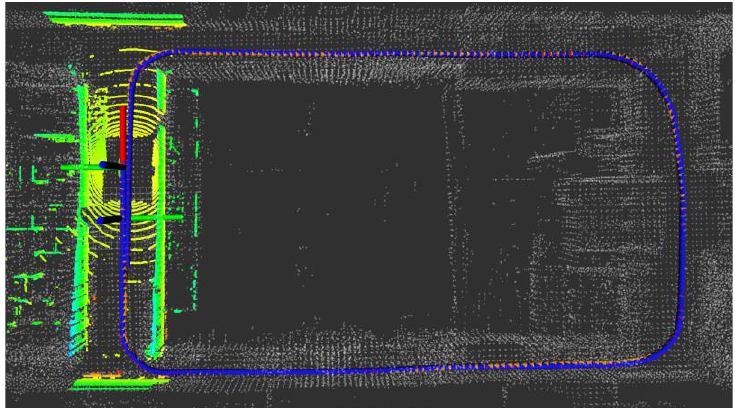
Figure 20. Field test NO.1. One lap under normal driving scenario localization test in prior point cloud map. The white points in the figure are the point cloud map built by the offline mapping process, the red line is the trajectory of LiDAR matching results, the orange line is groundtruth, and the blue line is the fused trajectory.